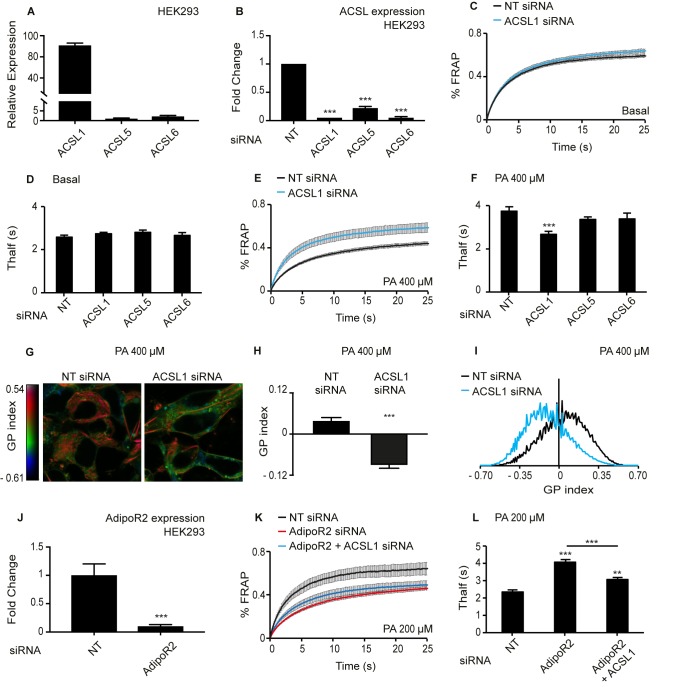
Knockdown of ACSL1 protects human HEK293 cells against the membrane-rigidifying effects of palmitate/AdipoR2 knockdown.(A) Relative expression levels of ACSL1, ACSL5 and ACSL6 in HEK293 cells as determined using qPCR. (B) Efficiency of ACSL1, ACSL5 and ACSL6 knockdown using siRNA relative to a non-target (NT) siRNA treatment in HEK293 cells. (C) FRAP analysis showing that siRNA against ACSL1 does not cause a change in membrane fluidity of HEK293 cells under basal conditions compared to NT siRNA treatment. (D) Thalf values from FRAP experiments with cells treated with the indicated siRNA and cultivated under basal conditions. None of the ACSL siRNA treatments differed significantly from the control NT siRNA; n ≥ 6. (E–F) As in C-D but in the presence of 400 μM palmitate (PA). Note that ACSL1 siRNA prevented membrane rigidification by palmitate, as evidenced by the significantly lowered Thalf; n ≥ 10 in F. (G) Pseudocolor images showing Laurdan dye global polarization (GP) index at each pixel position in HEK293 cells treated with NT or ACSL1 siRNA and cultivated in the presence of 400 μM palmitate (PA) for 24 hr. (H) Average GP index from several images as in G; n = 15. (I) Distribution of GP index values in representative images for each treatment under basal condition. (J) Efficiency of AdipoR2 knockdown using siRNA relative to a control NT siRNA treatment in HEK293 cells. (K) FRAP analysis showing that AdipoR2 siRNA causes membrane rigidification in HEK293 cells cultivated in the presence of 200 μM PA and that ACSL1 siRNA prevents this rigidification. (L) Thalf values from FRAP experiments as in K; n ≥ 13. Statistically significant differences from control are indicated, where **: p<0.01 and ***: p<0.001.